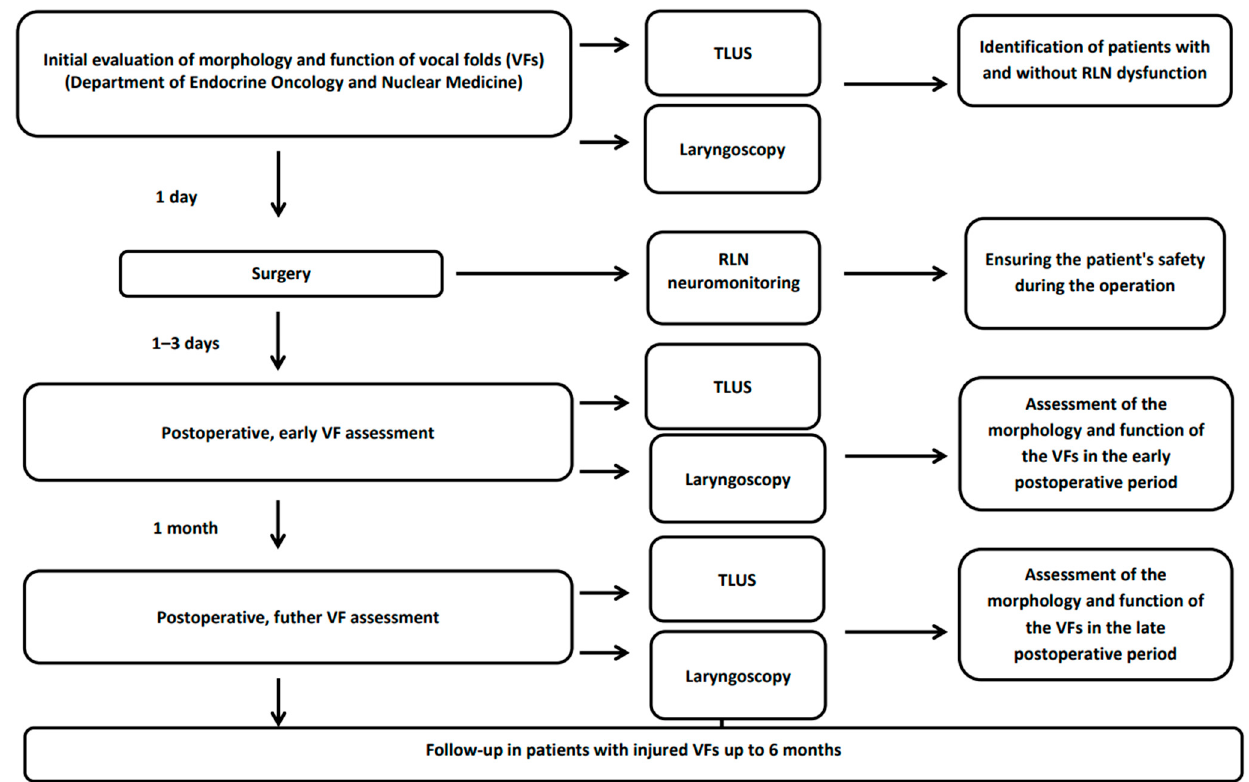
Figure 1. Scheme of the study. RLN—recurrent laryngeal nerve; TLUS—translaryngeal ultrasound; VF—vocal fold.